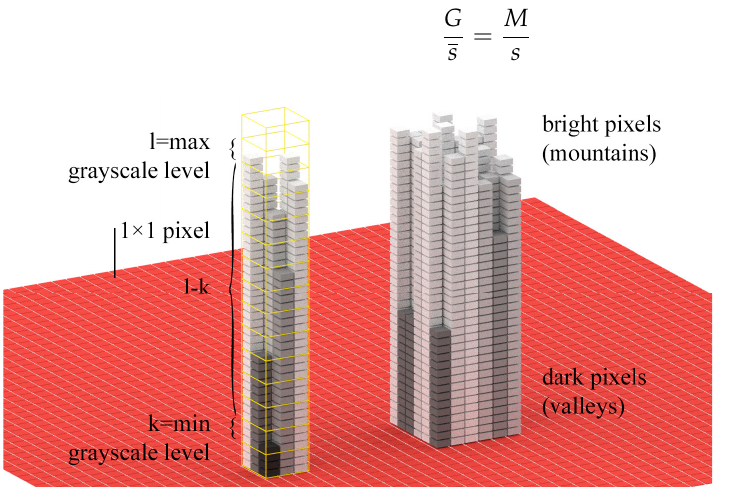
Figure 4. Differential box-counting method for grayscale images. The yellow highlighted stack of cubes shows the difference between the brightest and darkest pixel for one specific cell ( i ; j ) of a certain grid size.